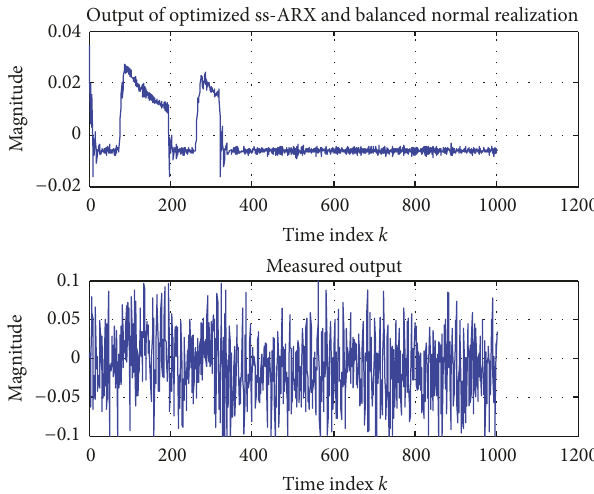
Figure 12: Simulated and measured output using optimized ARMAX (balanced realization) model at flow coef.